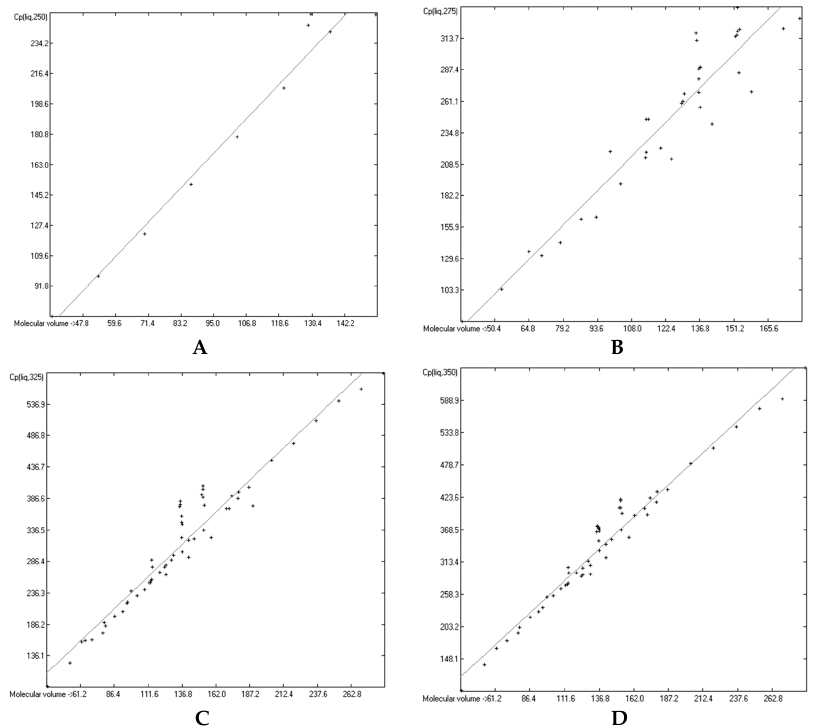
Figure 16. Correlation of molecular volumes with liquid heat capacities of OH-carrying compounds at